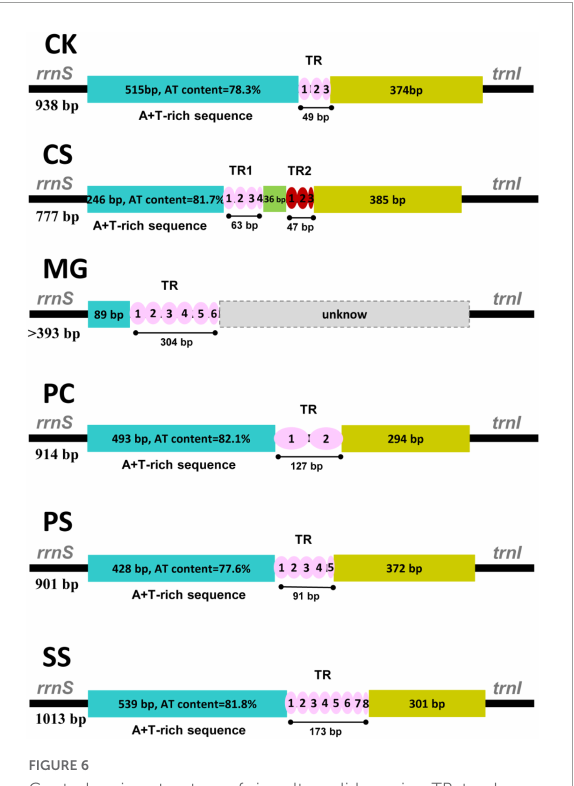
FIGURE6 Control region structure of six peltoperlid species. TR, tandem